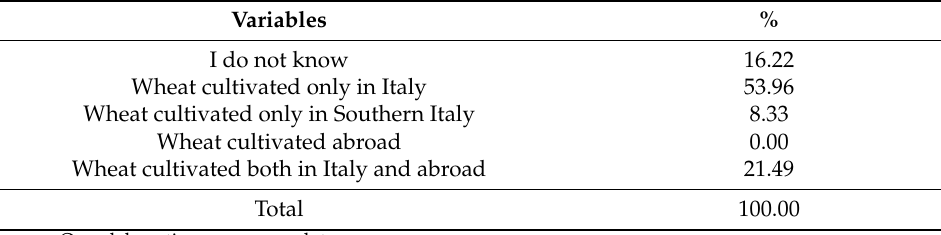
Table 4. Knowledge of the origin of durum wheat used to make the consumed